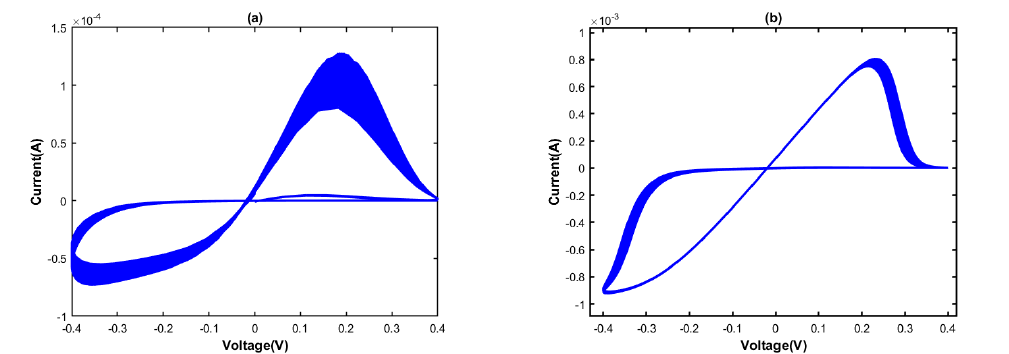
Figure 17. Monte Carlo simulation of the proposed memristor: ( a ) 16 nm and ( b ) 45 nm.